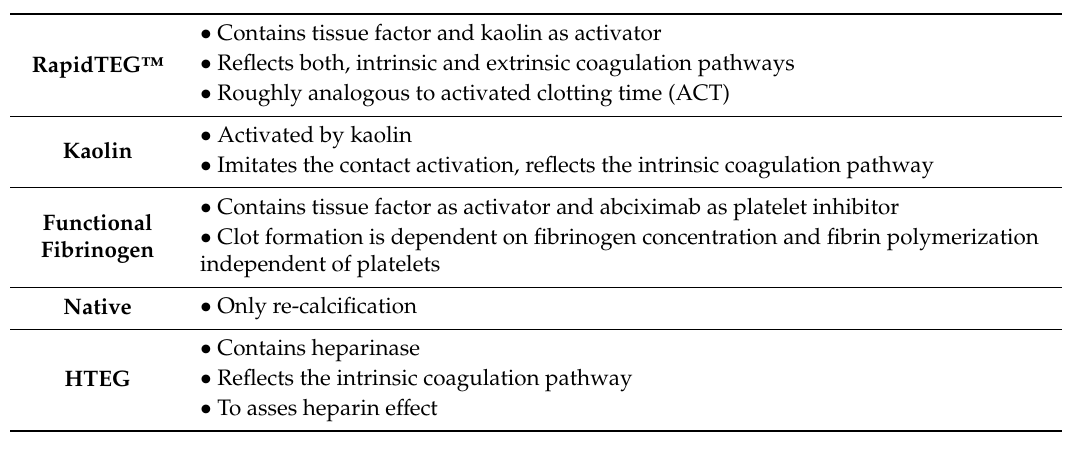
Table 2. TEG ® assays. The left column lists the main tests with the corresponding descriptions of content, activation, coagulation determinants and usage on the right column.